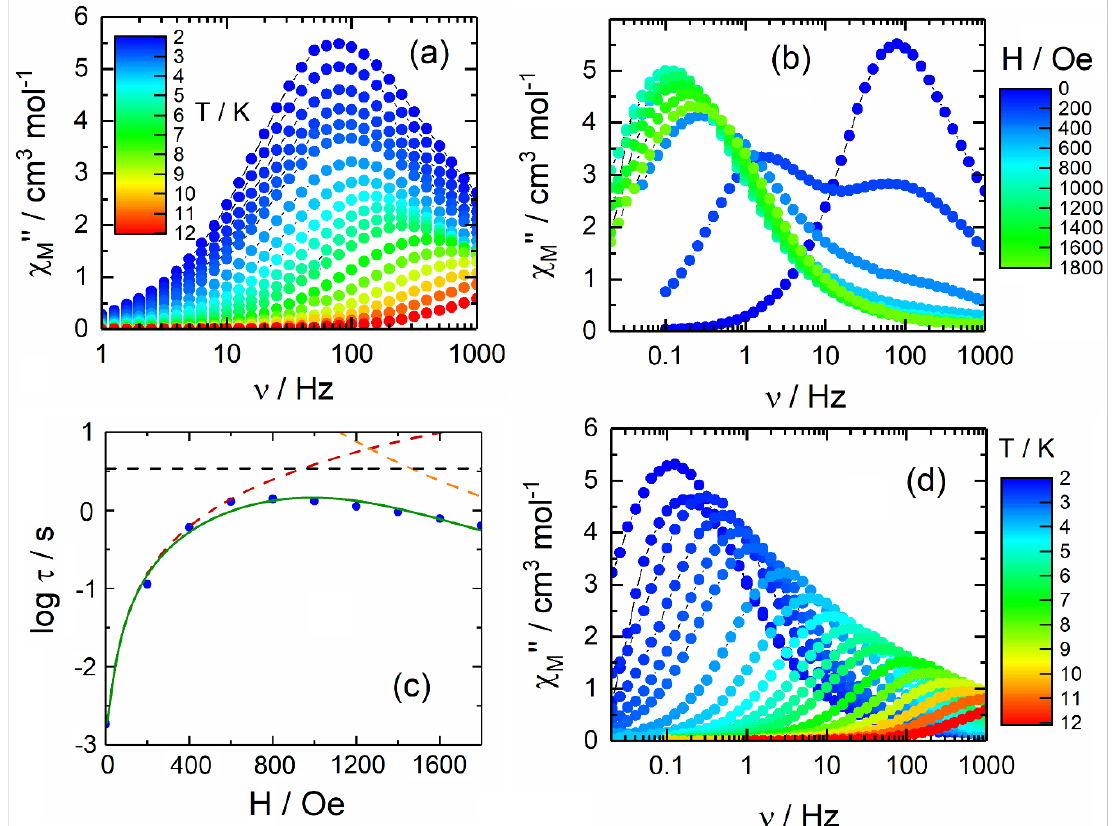
Figure 2. ( a ) Frequency dependence of χ M ″ at zero applied magnetic field for 1 in the temperature range of 2 – 12 K. ( b ) Frequency dependence of χ M ″ for 1 at 2 K in the 0 – 1800 Oe field range. ( c ) Field dependence of the relaxation time at 2 K for 1 with representation of the best fit curve (full green line) and the QTM (red dashed line), direct (orange dashed line) and thermally activated (black dashed line) contributions. ( d ) Frequency dependence of χ M ″ at 1000 Oe applied magnetic field for 1 in the temperature range 2 – 12 K.